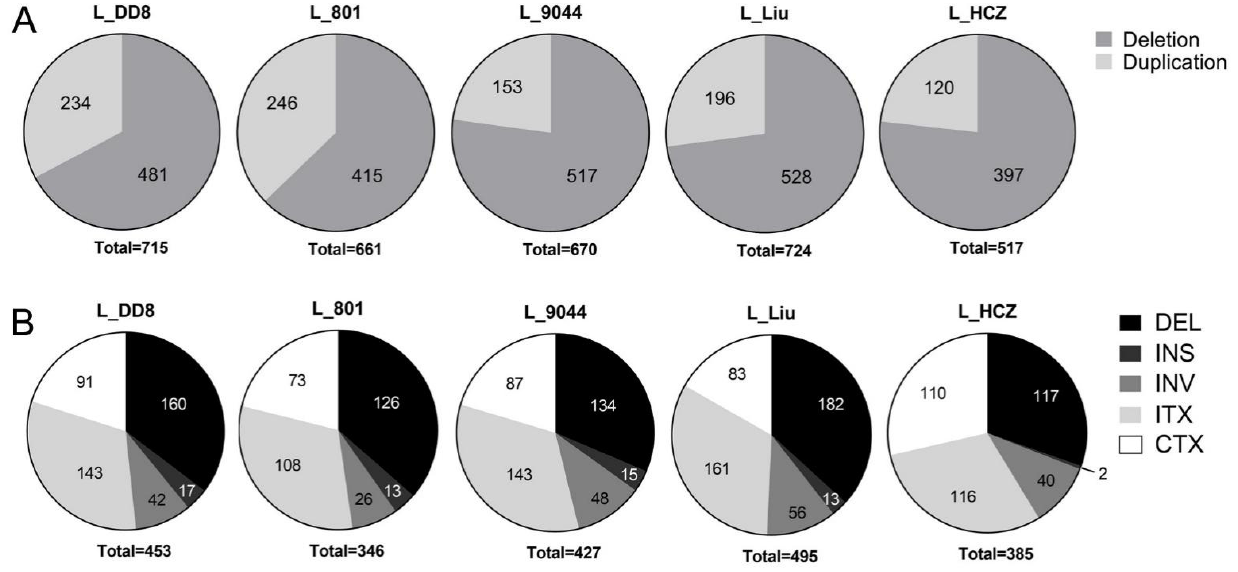
Figure 4. CNV and SV results. ( A ) Copy number variations of the five Leishmania isolates. ( B ) Structural variations of the five Leishmania isolates. DEL: Deletion. INS: Insertion. INV: Inversion. ITX: Intrachromosomal translocation. CTX: Interchromosomal translocation.